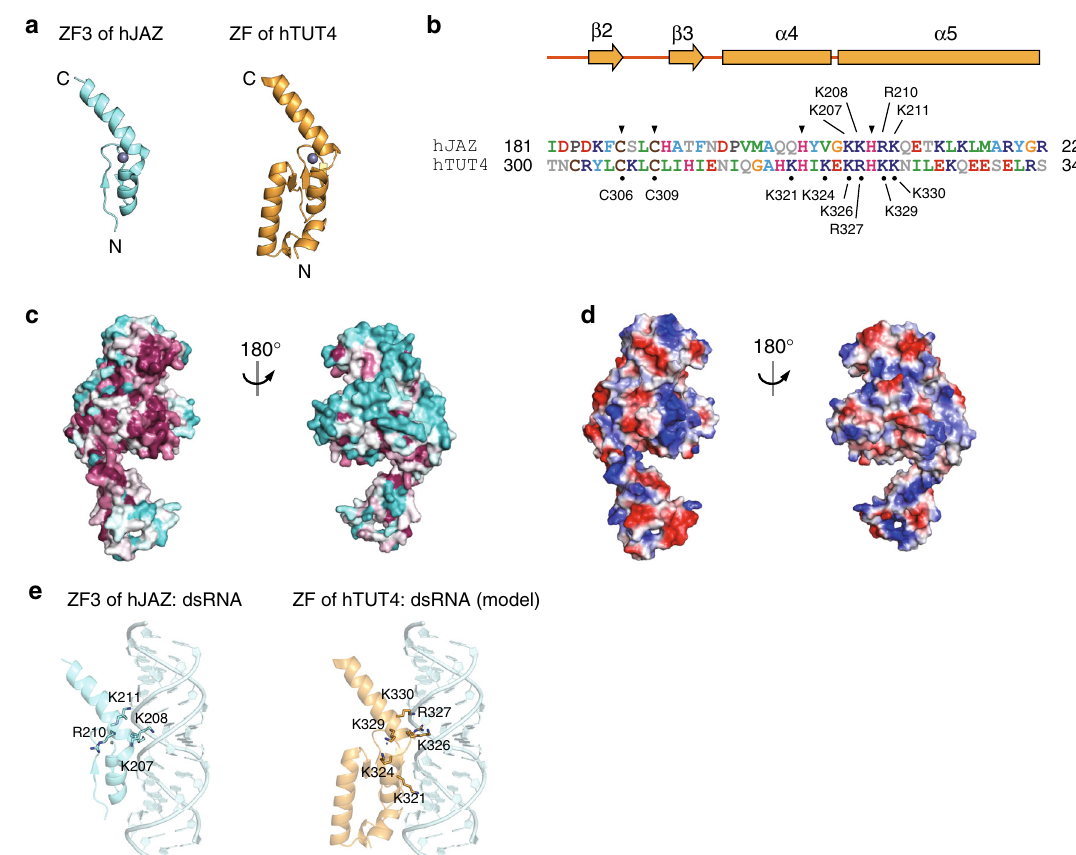
Fig. 3 Zinc fi nger (ZF) of the LIM of human TUT4. a Structural similarity between the third zinc fi nger domain of human JAZ (PDB ID: 2MKN, left) 45 and the ZF of human TUT4_N (right). b Sequence alignment of hJAZ_ZF3 and the ZF of hTUT4_N. The zinc-coordinating residues are indicated by arrowheads. The residues mutated in the biochemical assays are indicated by dots. c Conservation analysis of hTUT4_N. Conserved and non-conserved residues are colored purple and cyan, respectively. d Electrostatic surface potential of hTUT4_N. The positively and negatively charged regions are colored blue and red, respectively. e Docking model of the ZF of hTUT4_N and the double-stranded RNA